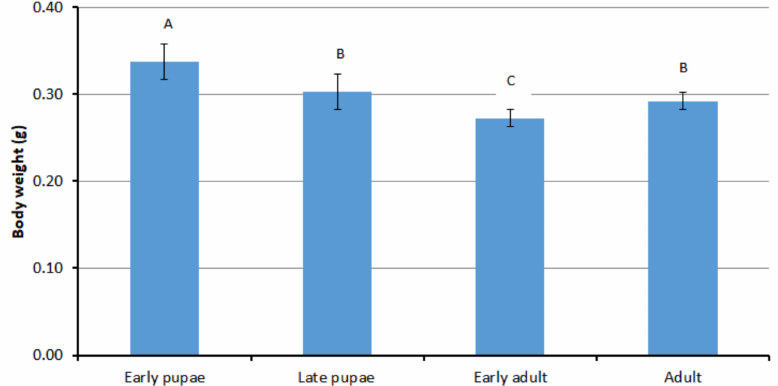
Figure 1. Body weights of di ff erent developmental stages of Italian honey bee drones from Korea. Di ff erent superscripts indicate statistically significant di ff erences ( p <